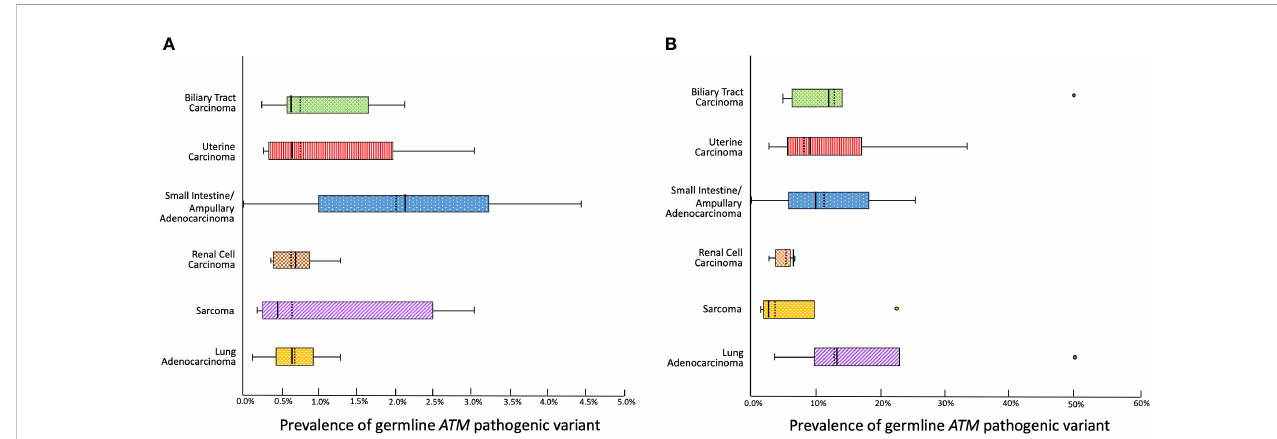
FIGURE 2 Box and whiskers plot depicting (A) The prevalence of a germline pathogenic ATM variant among individuals affected with each cancer type based on pooled data from a comprehensive review of cross-sectional studies. (B) The prevalence of a germline pathogenic ATM variant among individuals affected with each cancer who test positive for hereditary cancer predisposition (mean depicted with a solid vertical line, median depicted with a dashed vertical